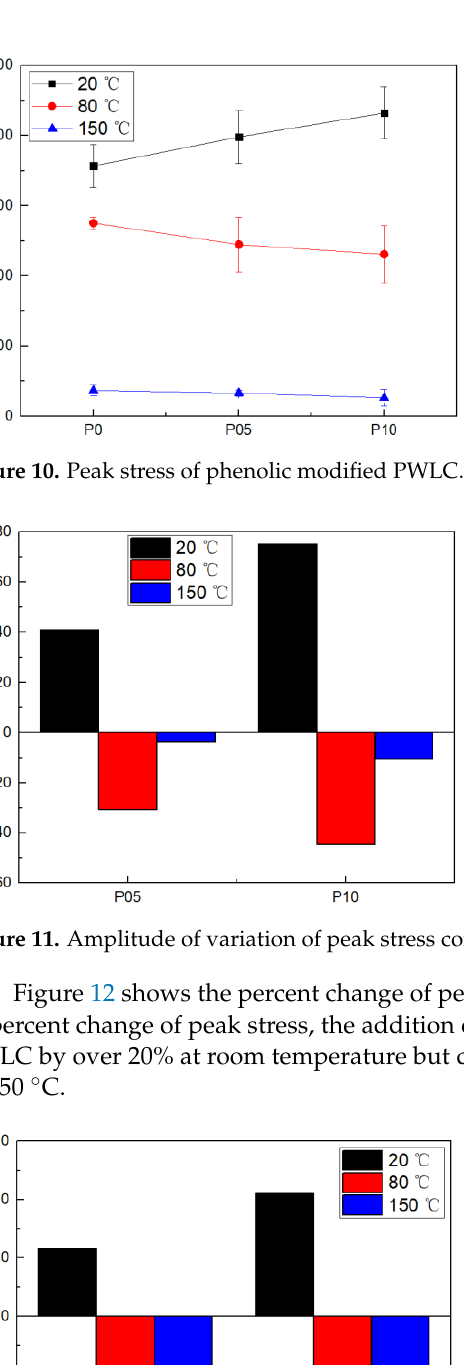
Figure 11. Amplitude of variation of peak stress compared with P0.